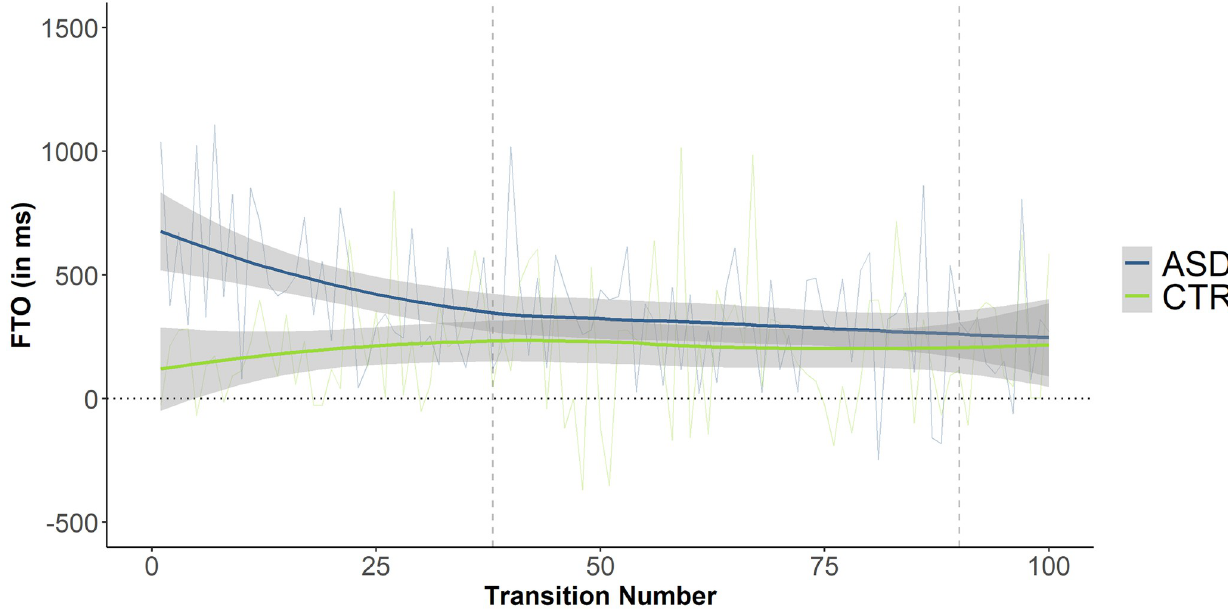
Fig 8. FTO values by turn transition and group. Positive values represent gaps; negative values represent overlaps. ASD group in blue, CTR group in green. Thin blue/green lines represent averaged FTO values by transition and group; thick lines represent fitted LOESS-smoothed curves by group, the surrounding grey shaded areas the respective standard error. The dashed vertical lines show 1) transition no. 38 (average time point for detection of first Mismatch) and 2) transition no. 90 (average time point for resolution of first Mismatch).